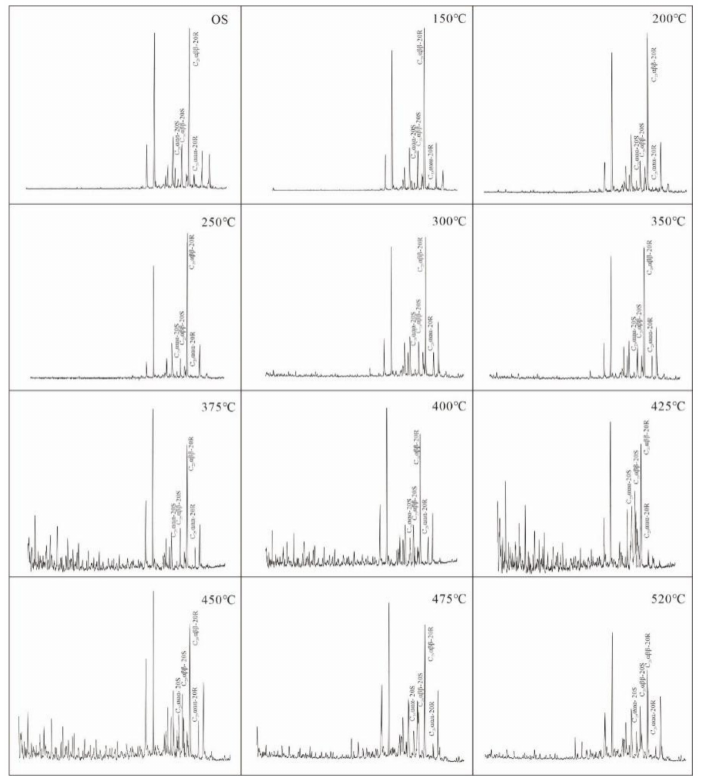
Figure 9. MS at different temperatures with mass chromatogram m / z =